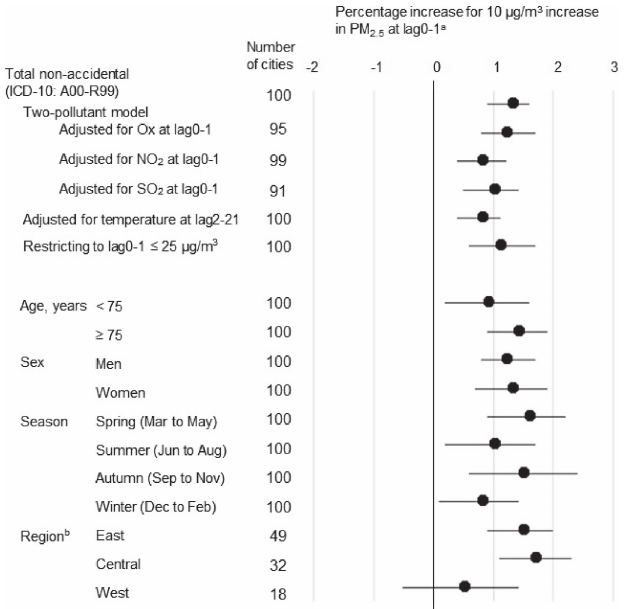
Figure 1. Sensitivity and strati fi ed analyses of the associa- tion between PM 2.5 exposure and total non- accidental mortality in 100 Japanese cities,